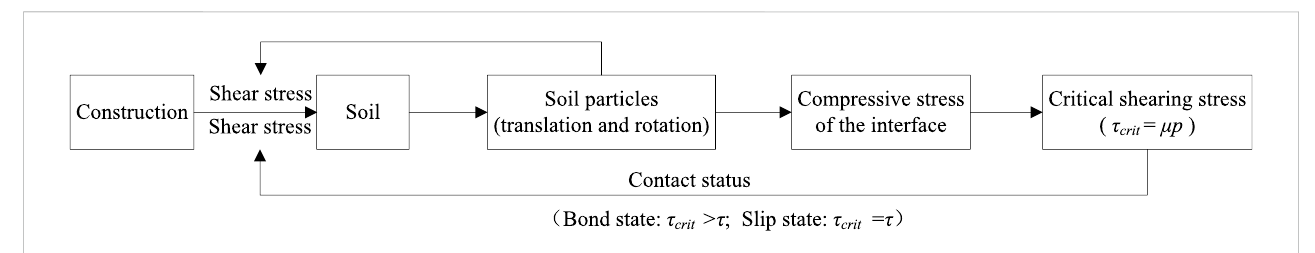
FIGURE 20 The evolution process of the soil-structure